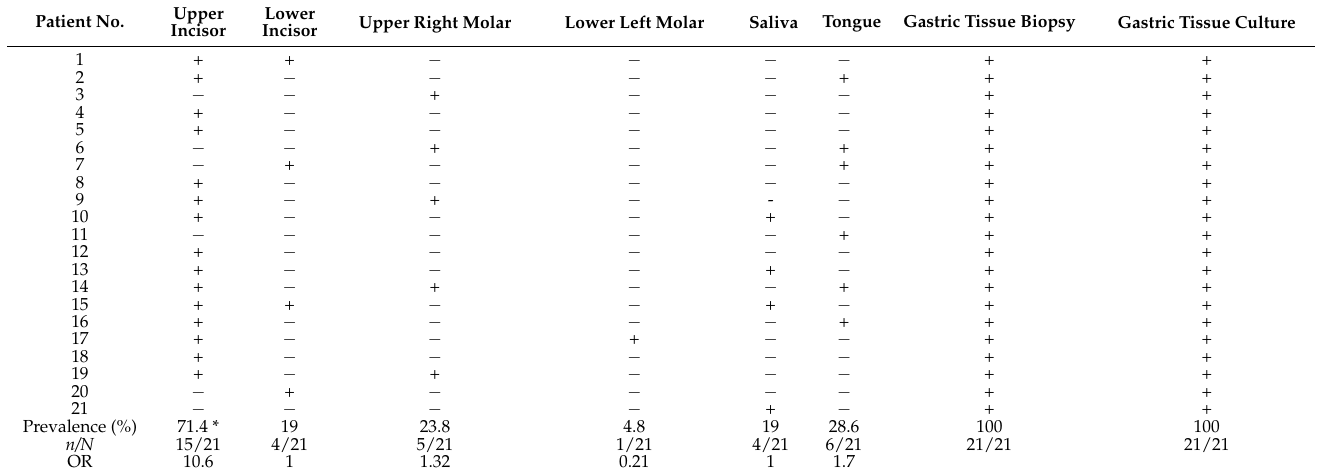
Table 2. Prevalence of H. pylori DNA in gastric tissue and by location in the oral cavity using nested PCR. Patient No. Saliva Tongue Gastric Tissue Biopsy Gastric Tissue Culture